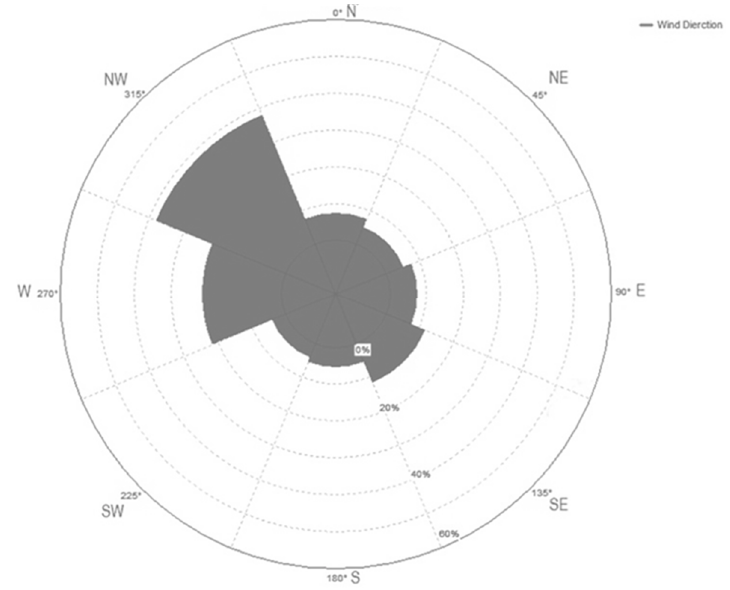
Figure 4. The wind height diagram for RAWA city.